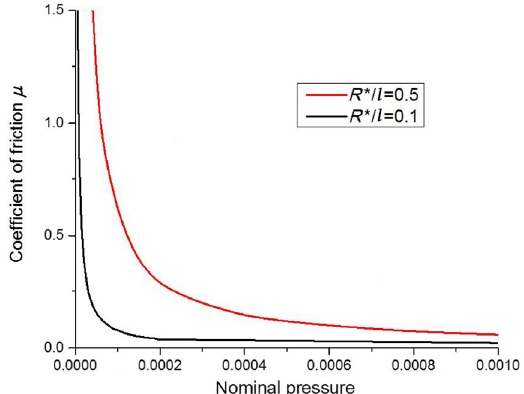
Fig. 6 Coefficient of friction vs nominal pressure. Fig. 7 Rolling scheme of a rough cylinder on an elastic half-space.